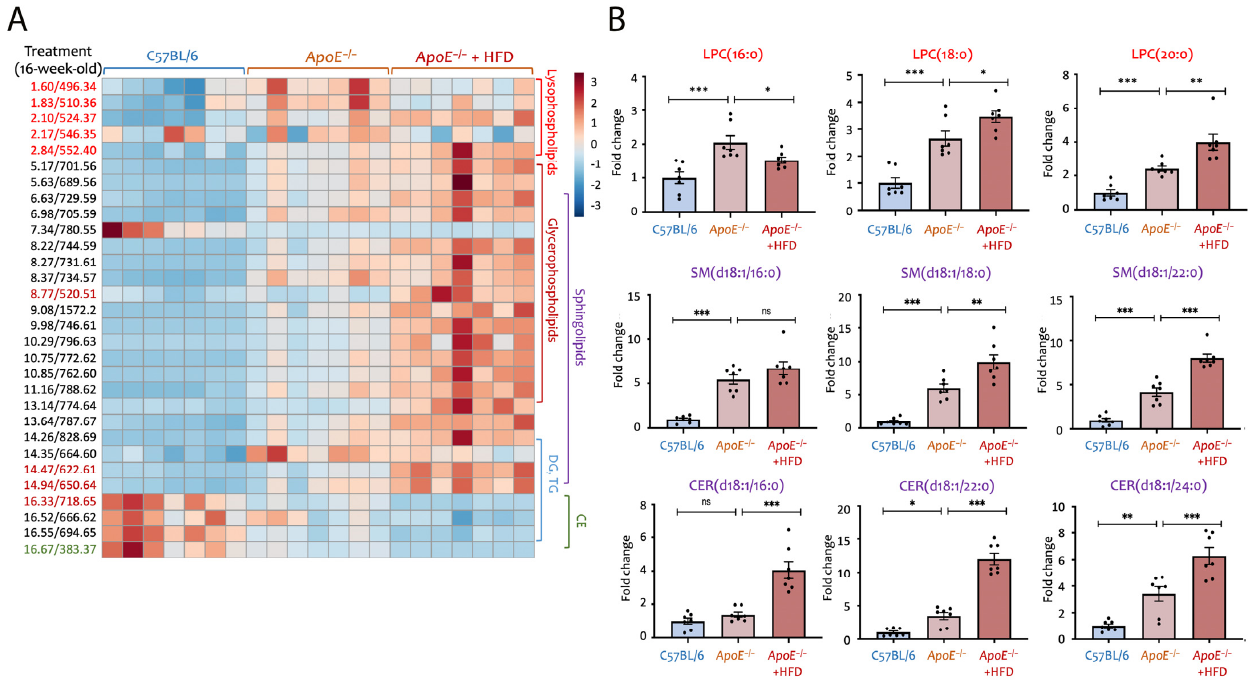
Figure 3. Elevated levels of sphingomyelin and ceramide in high-fat diet-fed apoE − / − mice. The analysis of untargeted lipidomic data was carried on as described earlier. ( A ) A total of 30 markers were picked from each category and displayed in a heatmap. Of the 30 markers, 27 were the same as those identi fi ed at the baseline. ( B ) LPC(16:0), LPC(18:0), LPC(20:0), SM(d18:1/16:0), SM(d18:1/18:0), SM(d18:1/22:0), CER(d18:1/16:0), CER(d18:1/22:0), and CER(d18:1/24:0) were the most abundant li- pid species in each category. Levels of each lipid species were compared among groups (N = 7 each).